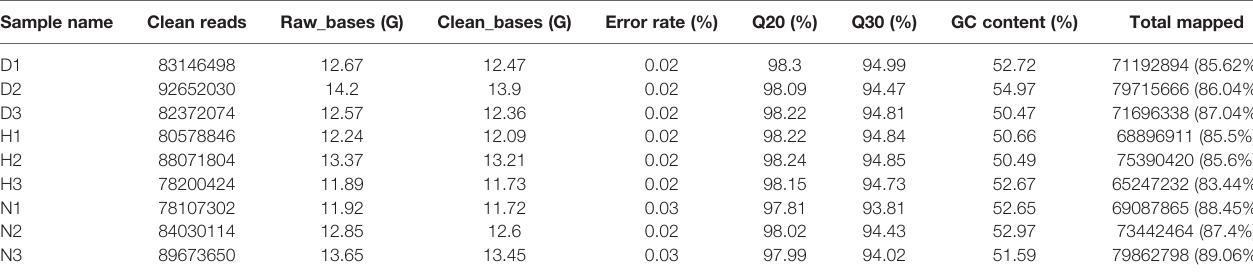
TABLE 2 | Major characteristics of lncRNA libraries and reads mapping to the duck reference genome.